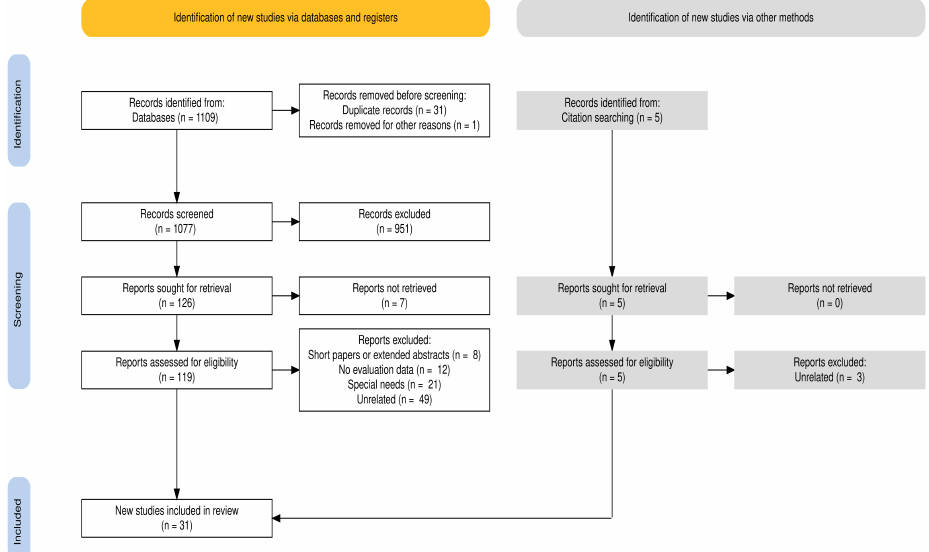
Figure 2. PRISMA flow